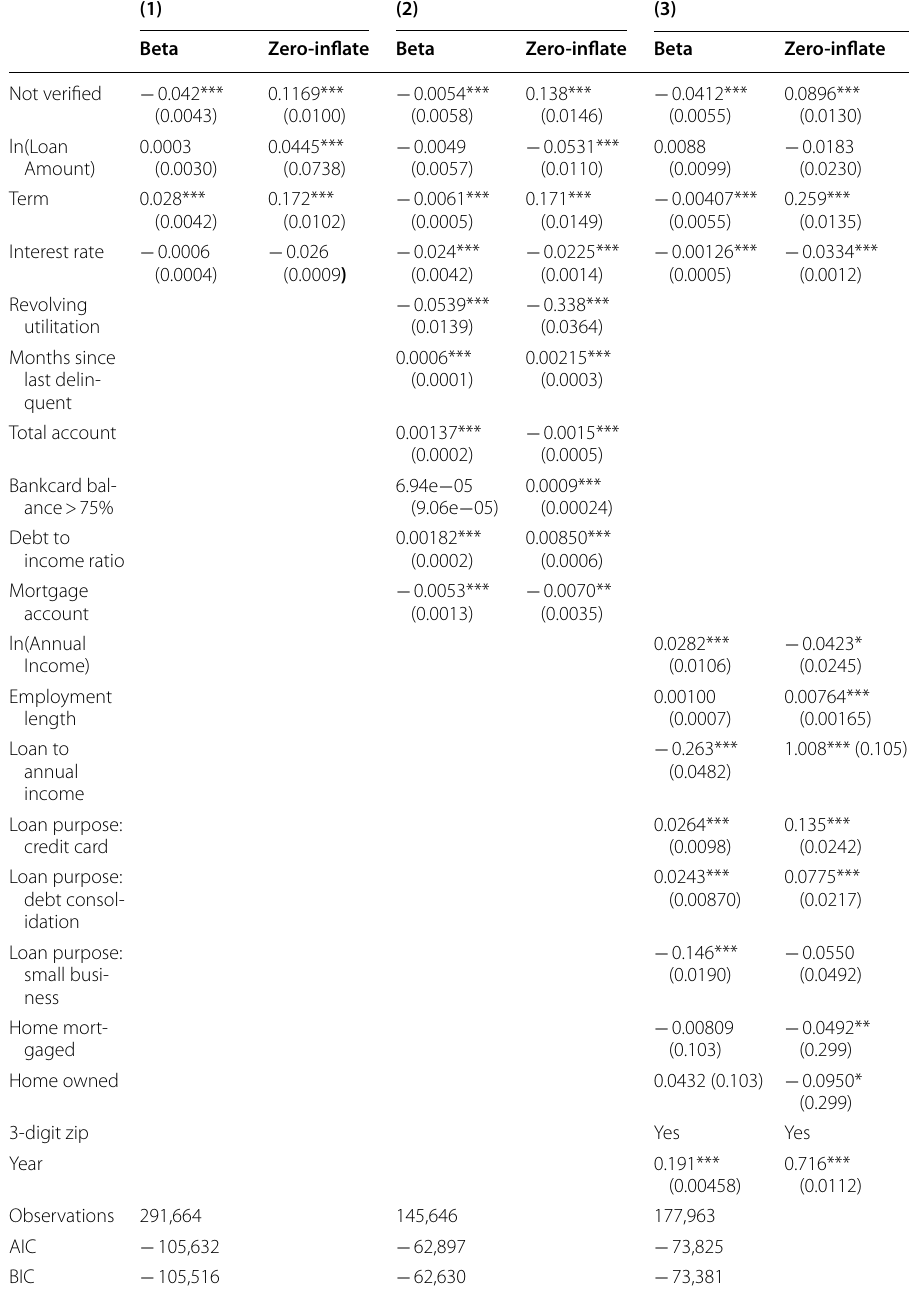
Table 8 Regression results recovery rate in the overall